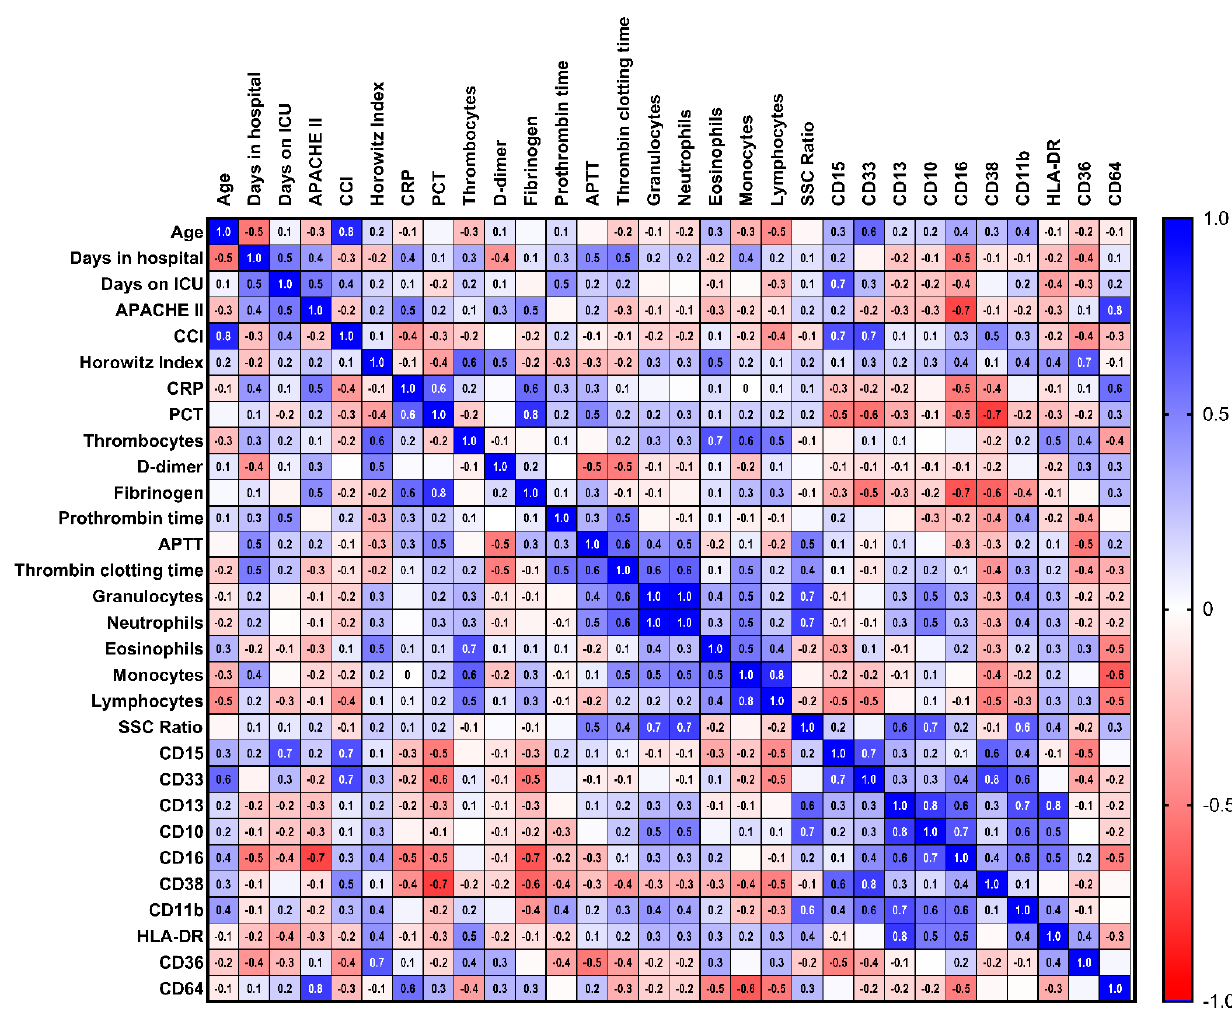
Figure 4. Correlation matrix of the neutrophil granulocytes and clinical parameters. Correlation matrix (heat map) of the immunophenotypic characteristics of the neutrophil granulocytes and clinical parameters of patients with COVID-19 in the ICU ( n = 12). Spearman’s ρ ranks between ± 1.0 (dark blue, dark red), high (inverse) correlation, and ± 0 (white), no correlation (abbreviations: ICU = intensive care unit; n = number; APACHE = acute physiology and chronic health evaluation; CCI = Charlson comorbidity index; CRP = C-reactive protein; PCT = procalcitonin; APTT = activated partial thromboplastin time; SSC = side-scatter).